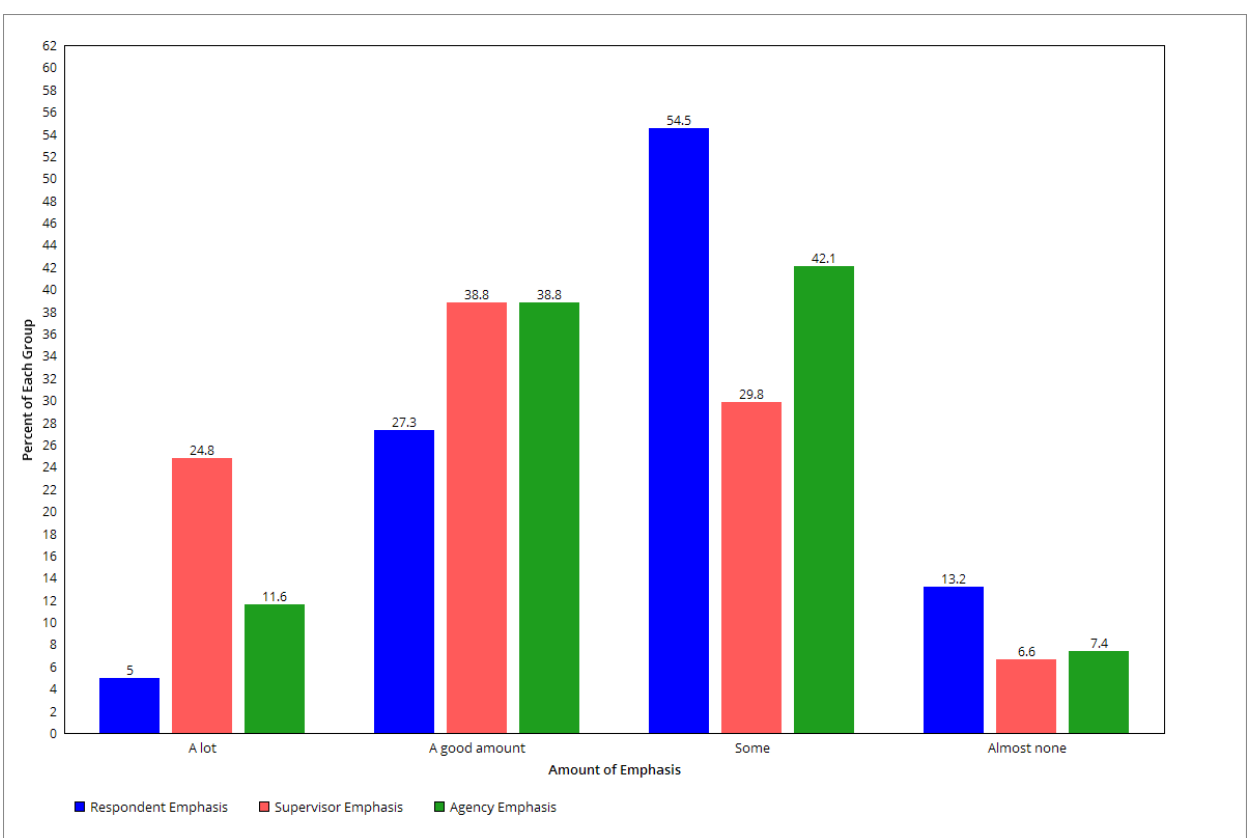
Figure 2. Respondent Perception of Amount of Emphasis Placed on Collection of Fees (N =